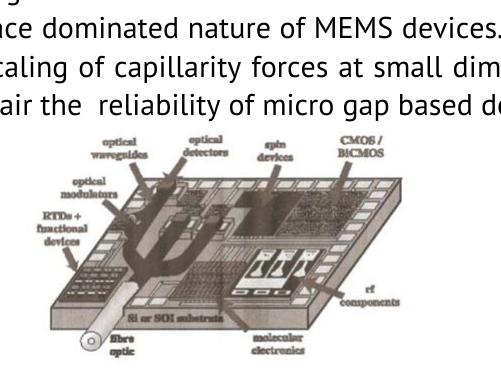
Figure 2. Fatigue cracks at the flip- chip